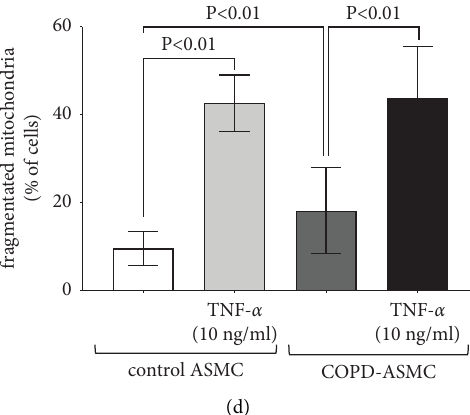
Figure 3: Te efect of TNF- α on ASMC miR-101-3p expression and mitochondria. (a) Bars show TNF- α upregulated miR-101-3p expression in ASMC from healthy nonsmokers (control) and COPD-ASMC ( n � 3/group). P values present comparison to time point 0. (b) Western blots for mitochondrial cytochrome c oxidase subunit II (MTCO2) degradation by TNF- α in ASMC of healthy nonsmokers (control, n � 3) and COPD-ASMC ( n � 3). Bars present mean ± S.E.M. of image analysis data. P values present comparison to time point 0. (c) Z-stack projection photos (Nikon Confocal, 60x magnifcation) of mitochondrial fragmentation, induced by TNF- α in ASMC of healthy nonsmokers (control) and COPD-ASMC. Mitochondria are indicated by staining of cytochrome c (green). (d) Image analysis of mi- tochondrial fragmentation is presented in Figure 3(c). Bars represent mean ± S.E.M. of cells with fragmented mitochondria, determined by double blind